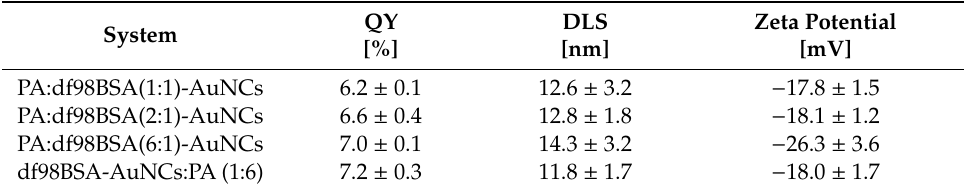
Figure 4. 3D excitation-emission maps of PA:df98BSA-AuNCs in molar ratios: ( A ) 1:1, ( B ) 2:1, and ( C ) 6:1. Note: Strong Rayleigh scattering first- and second-order maxima are visible as straight lines in these 3D maps and represent artifacts, which do not belong to the samples. Table 3. Calculated quantum yield (QY), hydrodynamic radius, and zeta potential values of the samples where PA was added to df98BSA at various molar ratios (PA:BSA being 1:1, 2:1, and 6:1) prior to or after AuNCs synthesis.